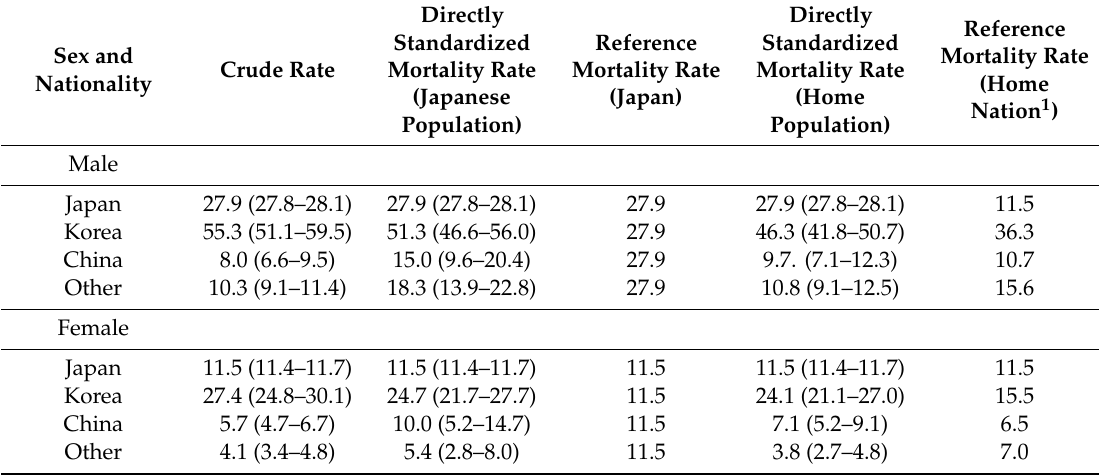
Table 1. Age-standardized suicide mortality rates by sex and